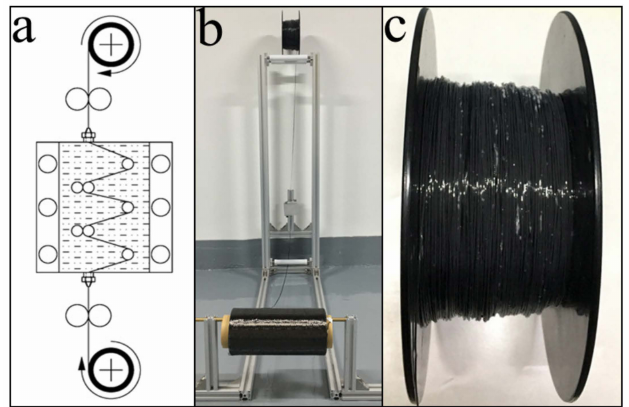
Figure 3. The as-designed impregnating equipment: ( a ) a schematic illustration of the impregnating process, ( b ) impregnating equipment, and ( c ) 3D printing filament of continuous fiber-reinforced thermosetting polymer composites (CFRTPCs).